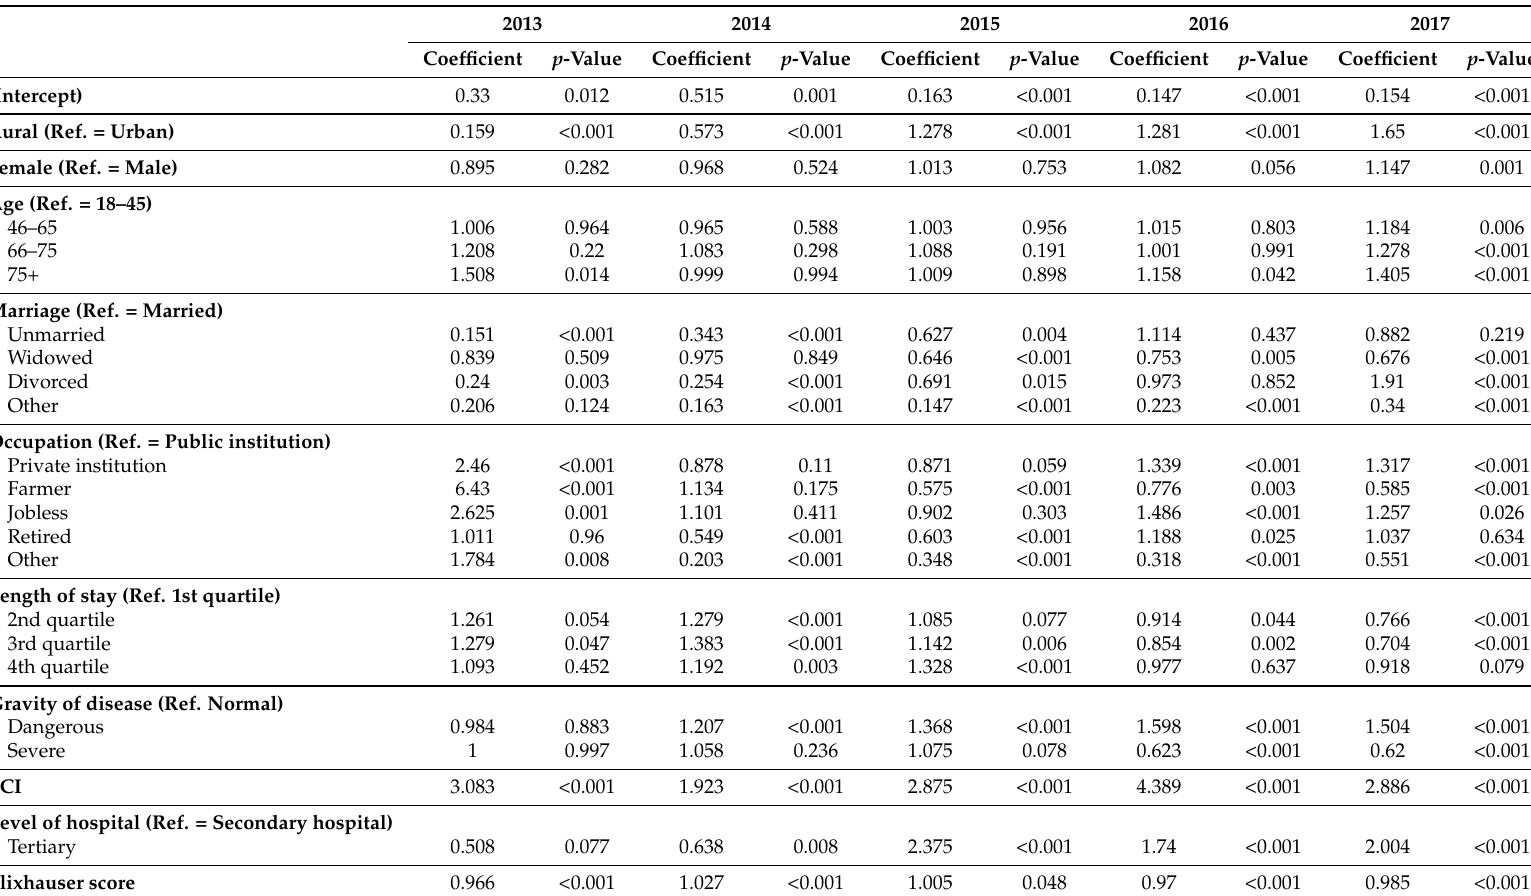
Table 3. Logistic regression results for whether OOP expenses were zero,